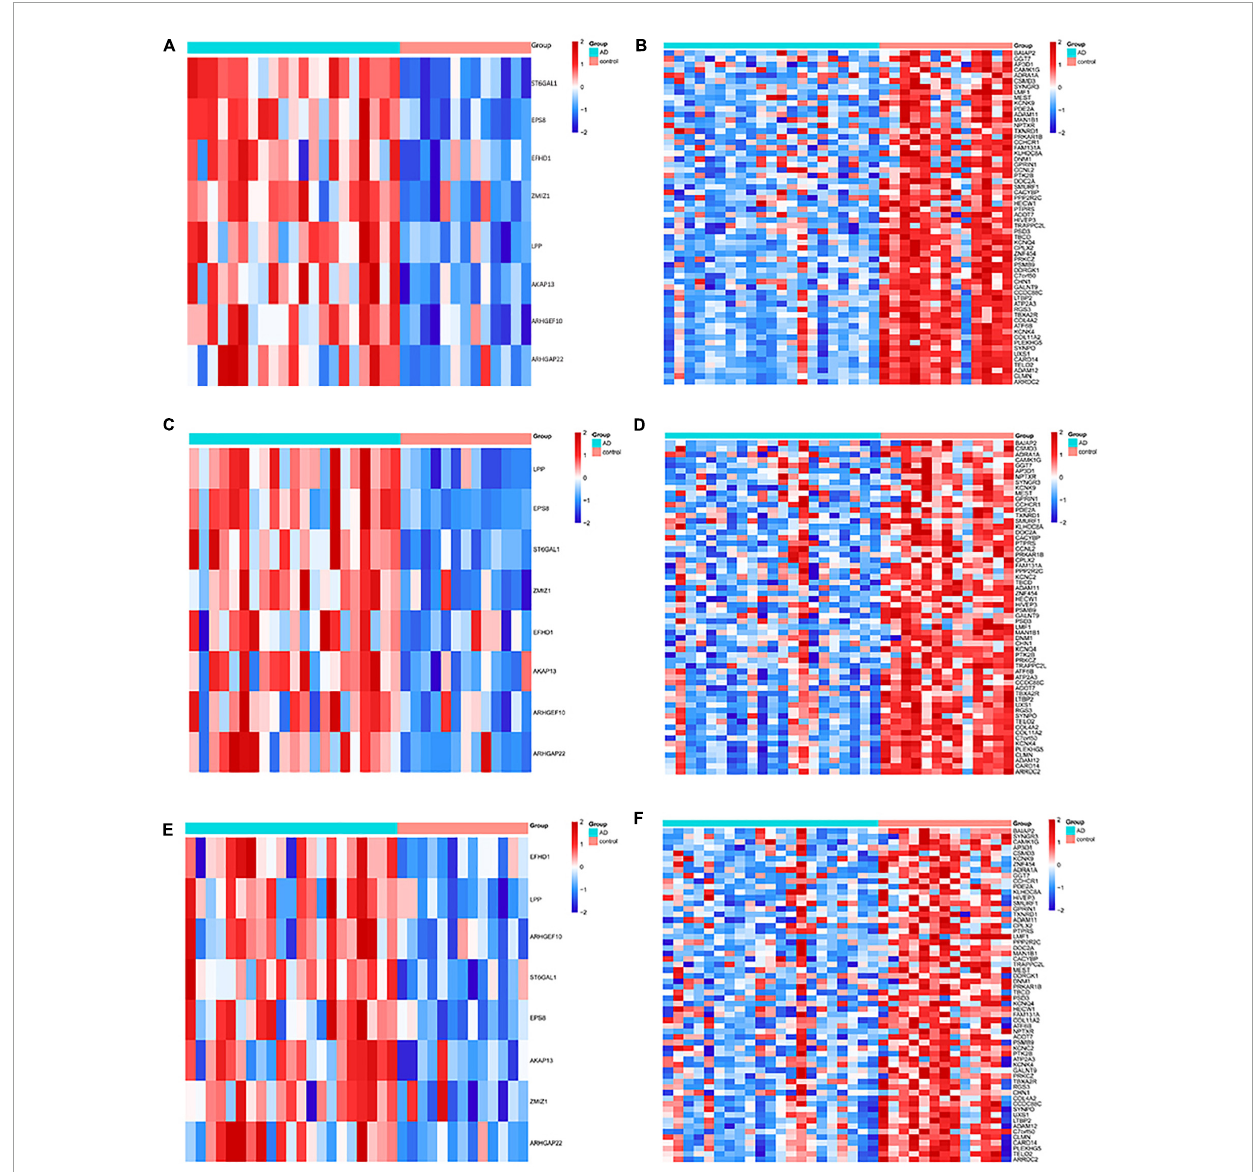
FIGURE4 Heatmap of the differentially expressed genes (DMGs) among the Alzheimer’s disease (AD) and healthy control (HC) groups in three brain regions. The heatmap reveals eight hypo-HG and 61 hyper-LG expressions in the (A,B) entorhinal cortex, (C,D) prefrontal cortex, and (E,F) superior temporal gyrus. Each column represents a sample, and each row represents the transcription expression level of all the samples involved in one